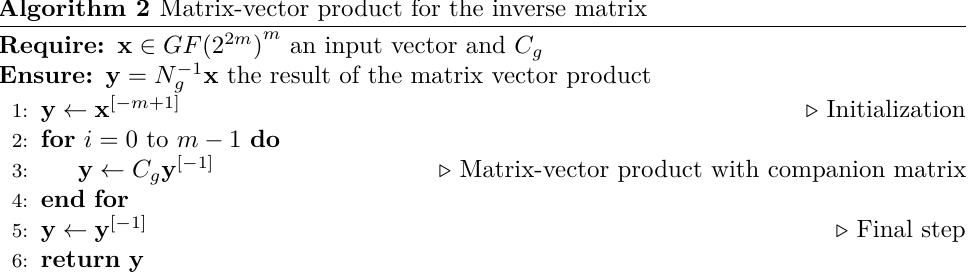
Algorithm 2 Matrix-vector product for the inverse matrix